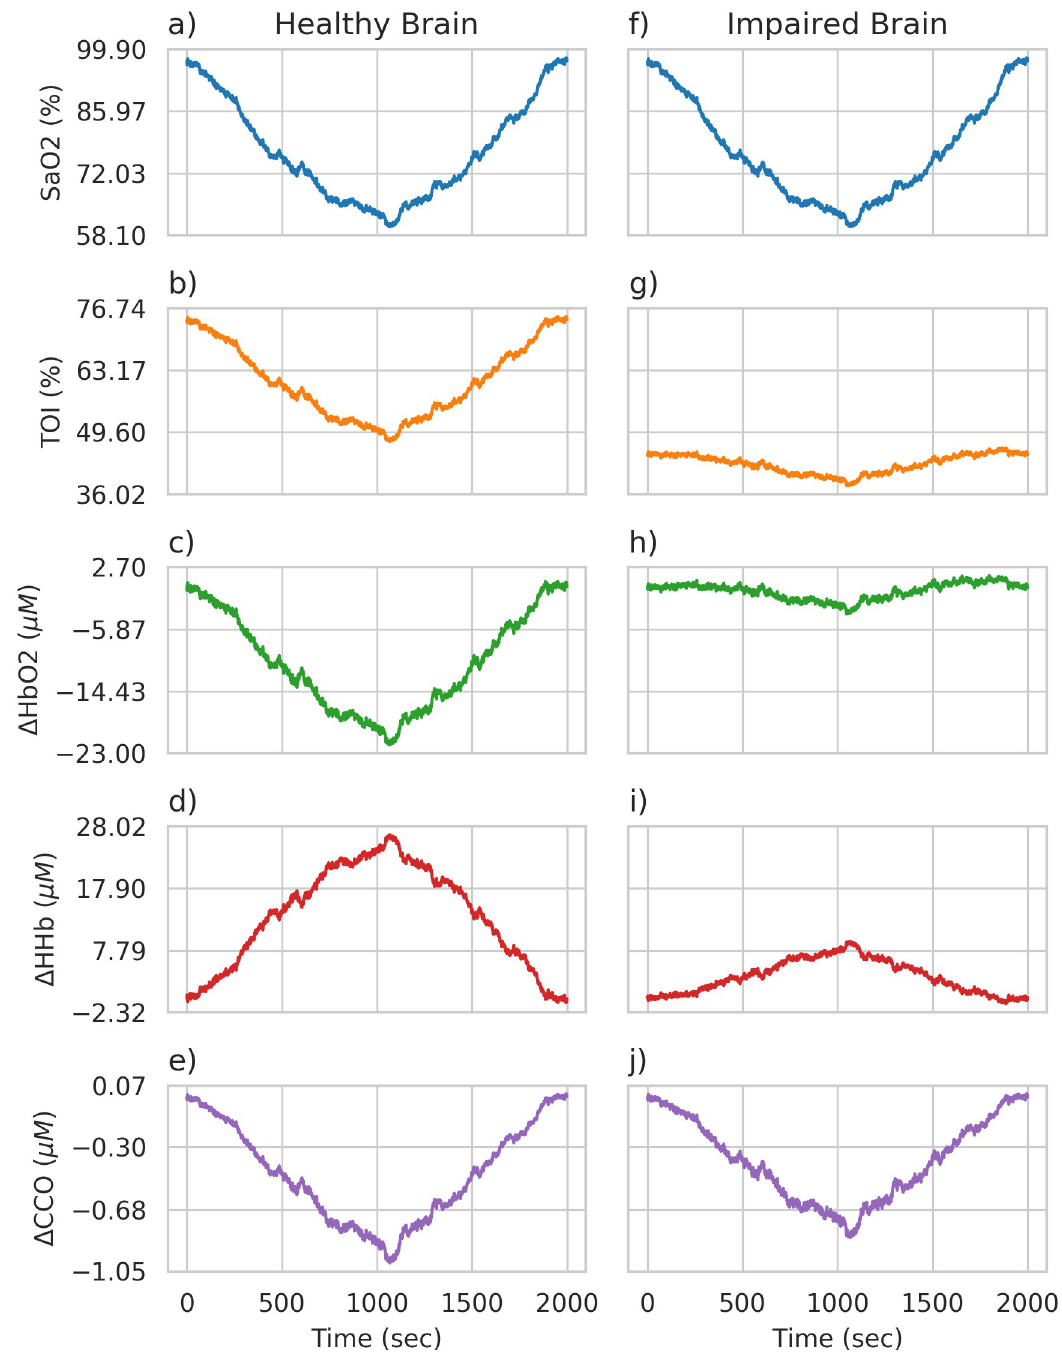
Fig 3. Healthy and impaired brain simulations. Figures a)-e) show simulations of a healthy brain’s response to hypoxia, whilst f)-j) show the impaired brain’s response. The input variable of arterial oxygen saturation is shown in blue and is the same for both simulations, whilst the outputs of TOI, Δ HbO 2 , Δ HHb and Δ CCO clearly differ between the two brain states.